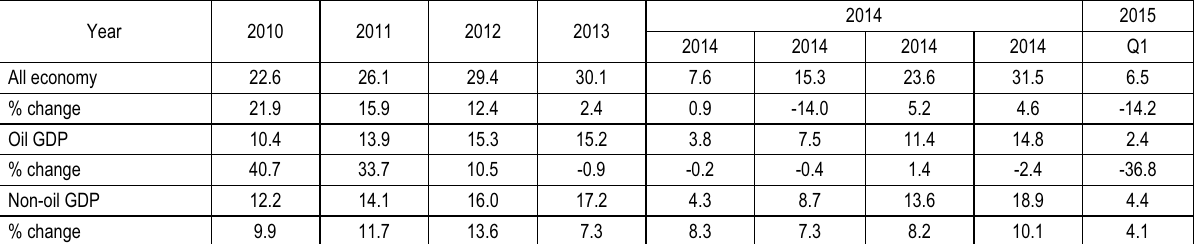
Table 1. GDP statistics of Oman (Rial Omani,